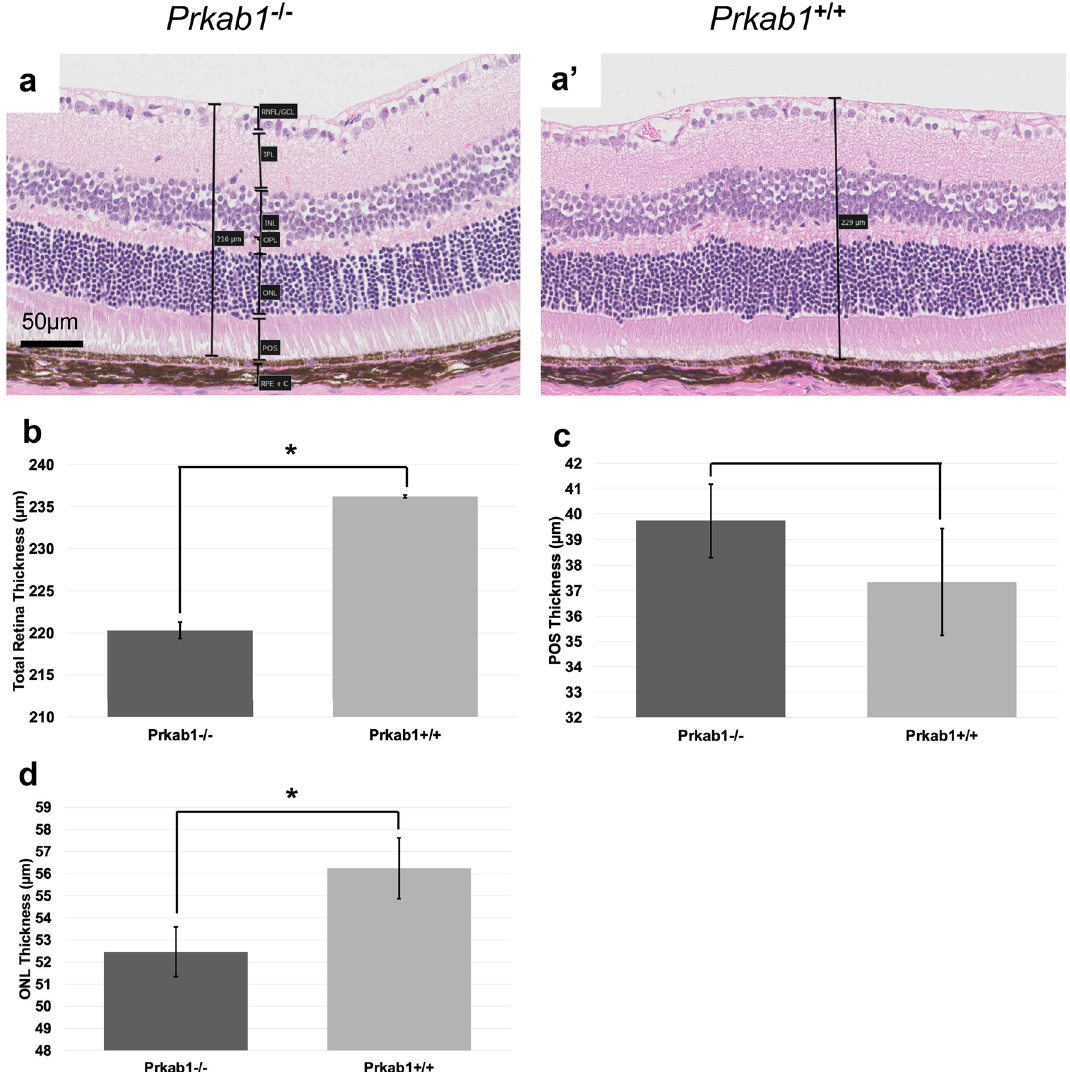
Figure 7. Prkab1 −/− mice have decreased total retinal thickness and reduced thickness of the ONL. ( a ) Prkab1 −/− mice retinas show decreased total thickness with evidence of reduced thickness in the ONL. ( b ) Quantitative measurement of average total retina thickness, where Prkab1 + / + n = 6567, average = 236.21 µm, SE = 0.19 and Prkab1 −/− n = 85, average = 220.29 µm, SE = .998. p = 1.078 × 10 –27 ( c ) Quantitative measurement of POS layer thickness where Prkab1 + / + n = 9, average = 37.33 µm, SE = 2.09 and Prkab1 −/− n = 14, average = 39.74 µm, SE = 1.43 p -value = .357 ( d ) Quantitative measurement of ONL thickness where Prkab1 + / + n = 11, average = 56.24 µm, SE = 1.37 and Prkab1 −/− n = 14, average = 52.57 µm, SE 1.12 p -value = .039. All error bars represent standard error of the mean, * indicates p -value < .05 result of student’s two-tailed t-test. Retinal layers abbreviated as